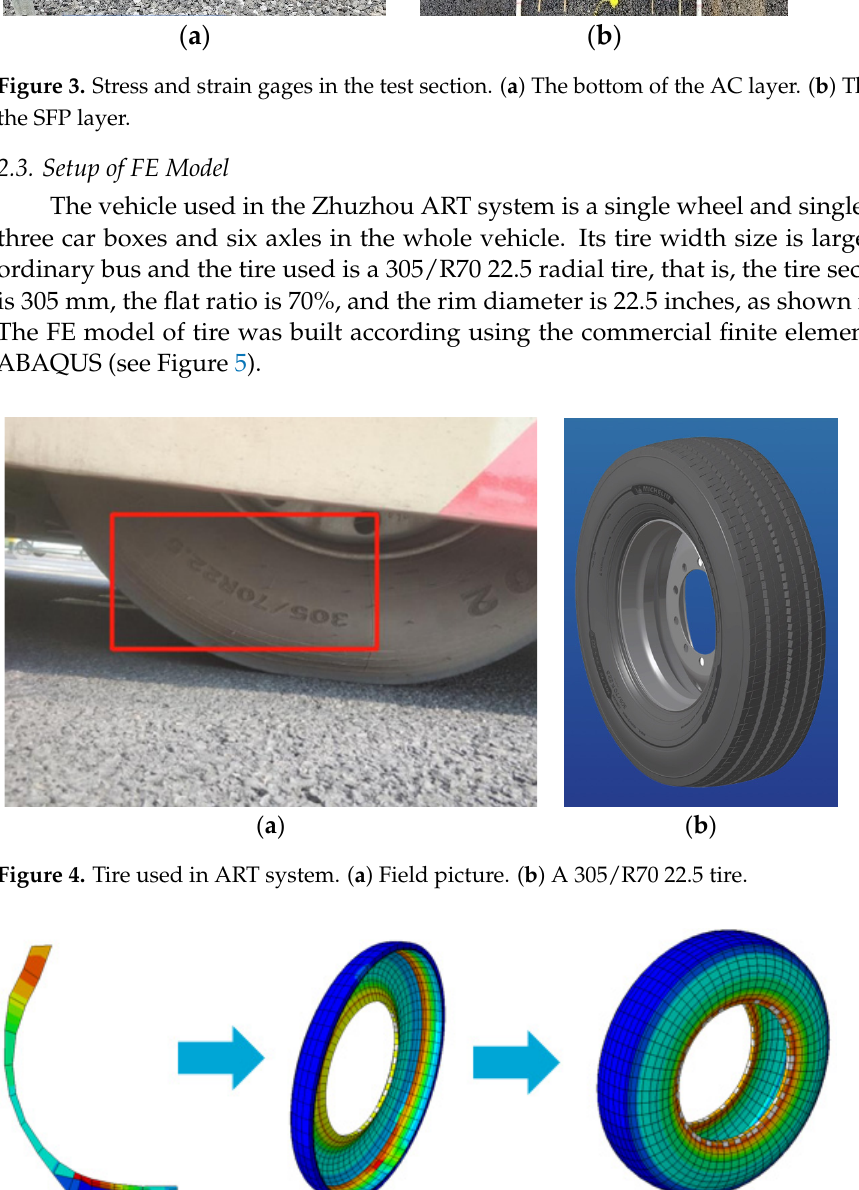
Figure 5. The FEM model of the 305/R70 22.5 tire .